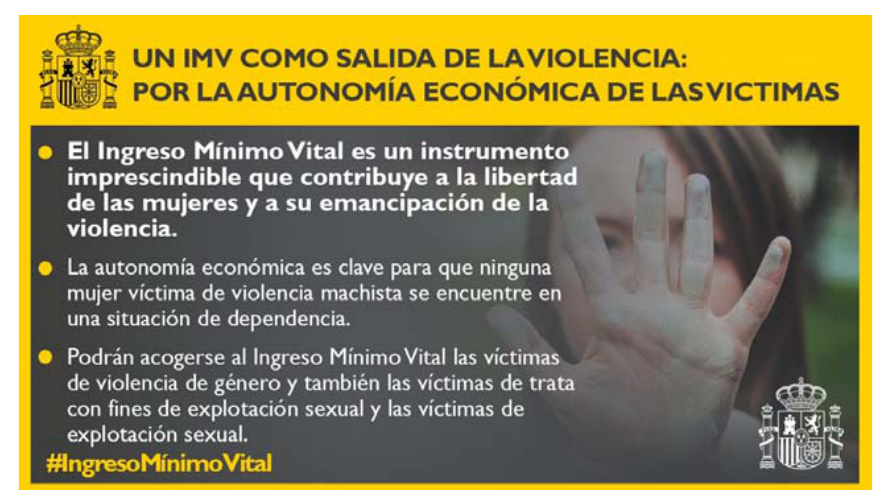
Figure 2. Infographic of the Government of Spain published on the IMV’s social networks as a “way out of violence”. Source: https://twitter.com/Iguald)adGob/status/1266331252015202304/photo/1 14 (accessed on 1 June 2021).